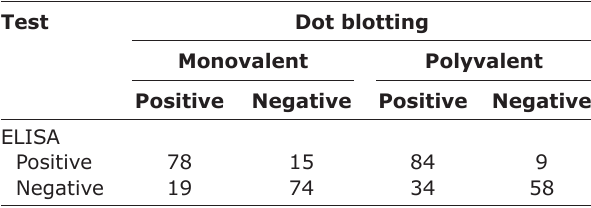
Table-1: The result of dot blotting using monovalent and polyvalent antigen of live attenuated African horse sickness virus vaccine compared to blocking ELISA.